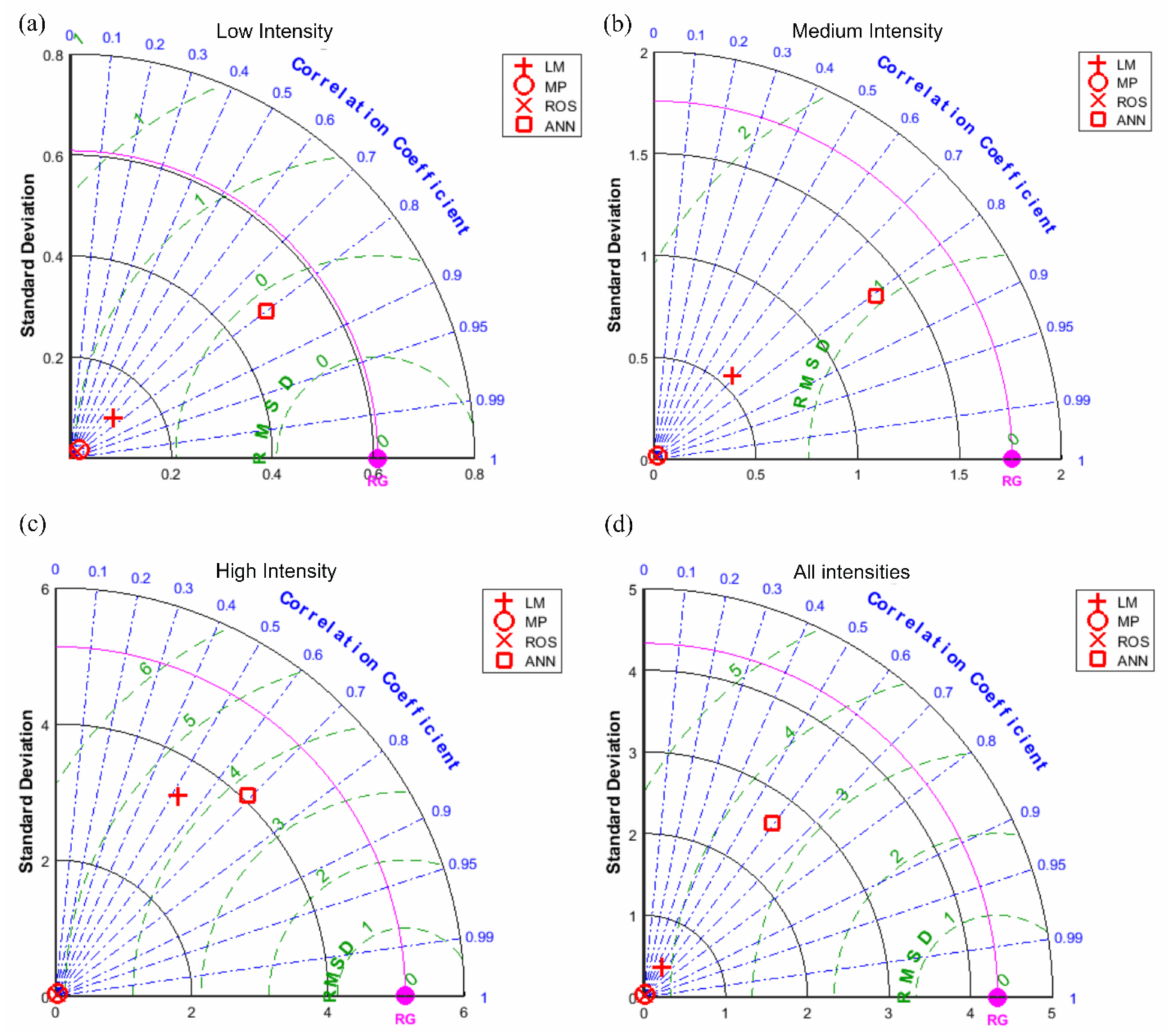
Figure 6. The Taylor diagram illustrating a statistical comparison of four different hourly radar rainfall estimates with rain gauge (RG) observation under different rainfall intensities: ( a ) low, ( b ) moderate, ( c ) high, and ( d ) all intensity. The azimuthal angle denotes correlation; the radial distance is standard deviation; and the semicircles centered at the RG represent residual mean square error